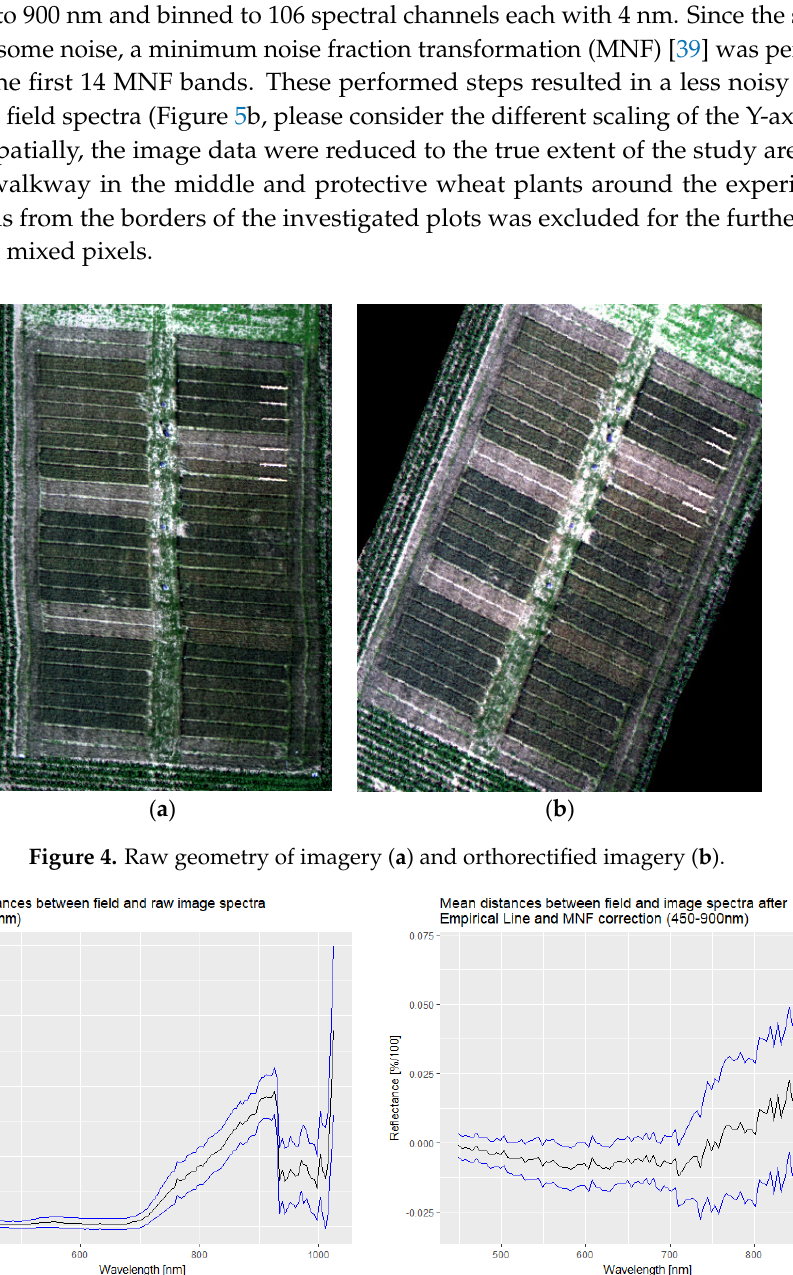
Figure 5. Mean distances between field and raw image spectra for each band ( a ) and mean distances between field and noise-reduced image spectra for each spectral band ( b ).